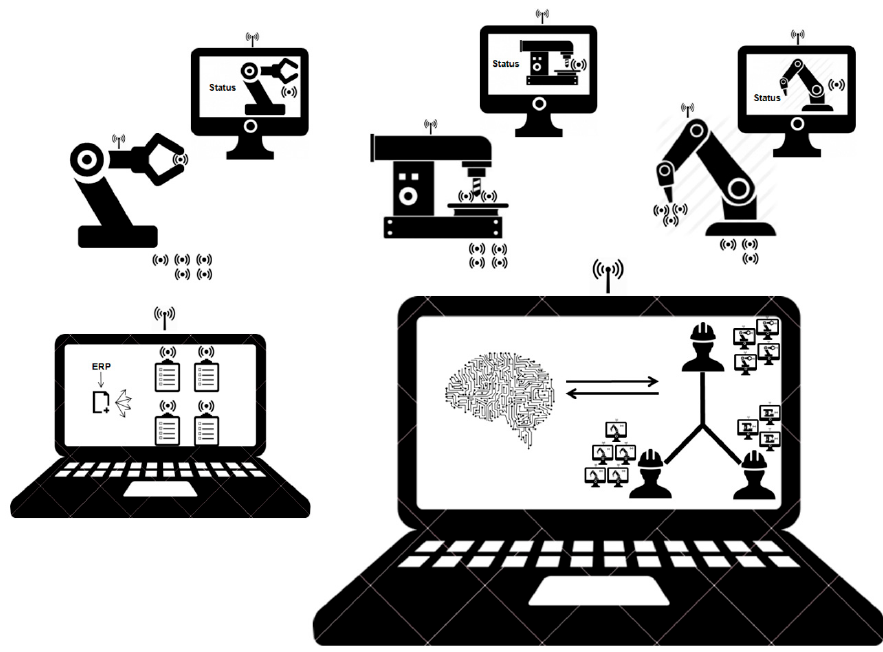
Figure 5. Job Shop Virtualization.